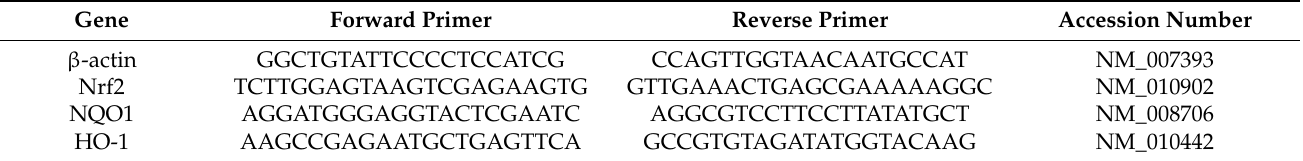
Table 1. Sequence of the